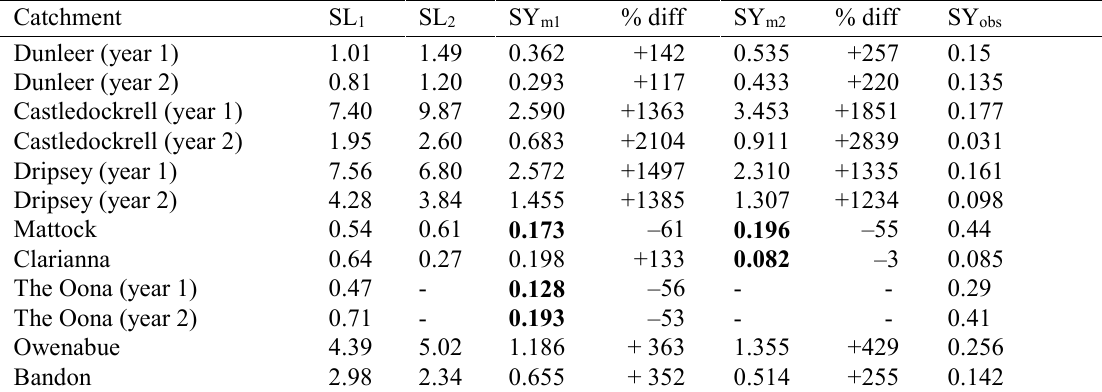
Table 3 Estimates of modelled soil loss and sediment yield for Irish catchments. Catchment